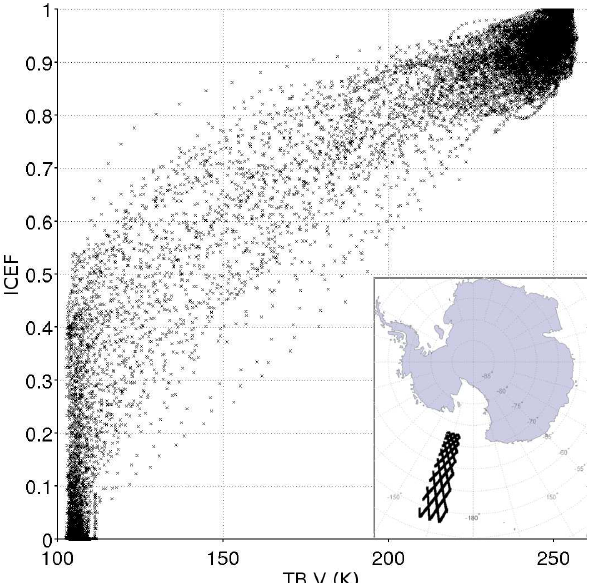
Fig. 11. ICEF as a function of TB V (radiometer 1) in and north of the Ross Sea (see embedded map with the location of the footprint measurements). Swath data from cycle 85 to 105 (i.e. between 4 April 2013 and 29 August 2013.